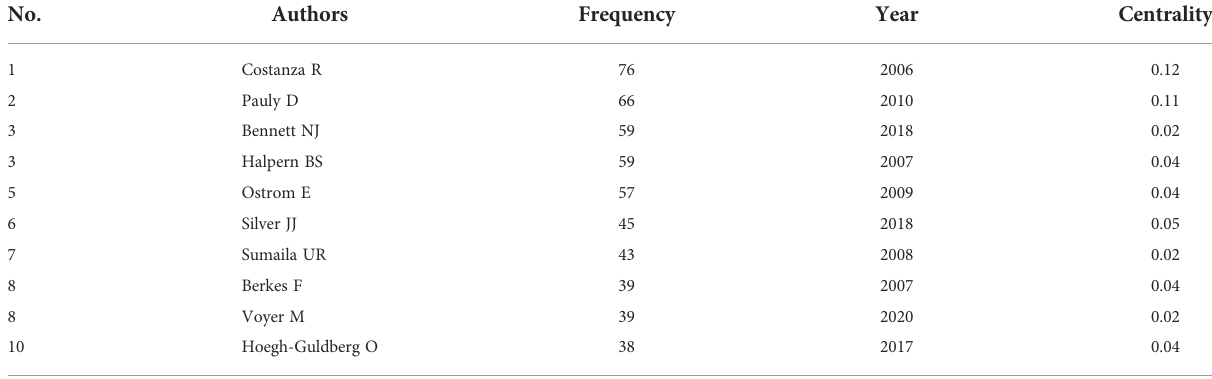
TABLE 6 The top 10 cited authors based on frequency.